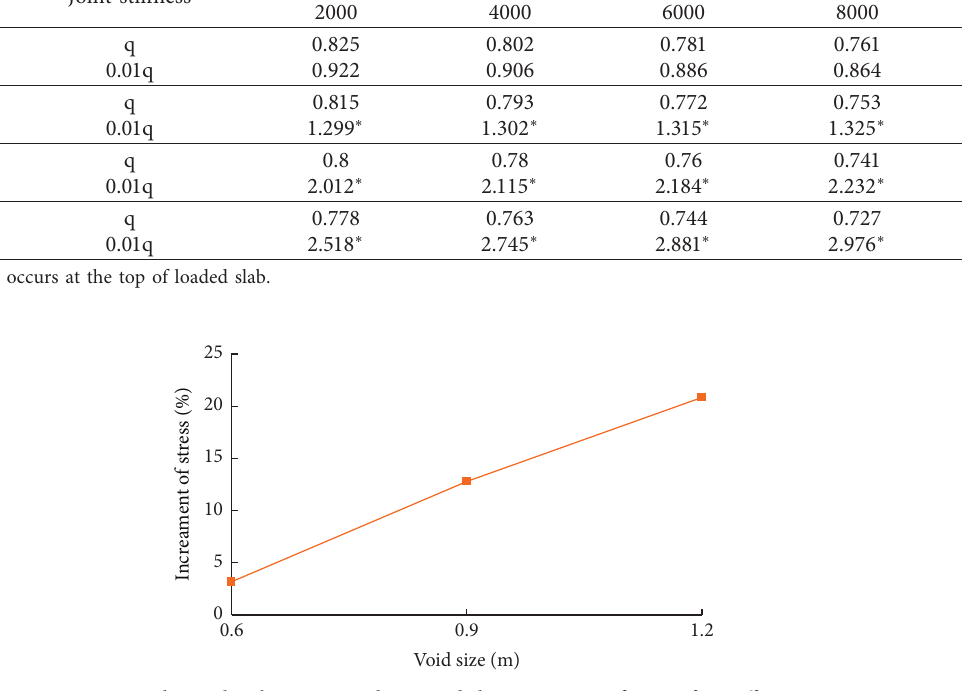
Figure 19: Relationship between void size and the increment of stress for stiffness